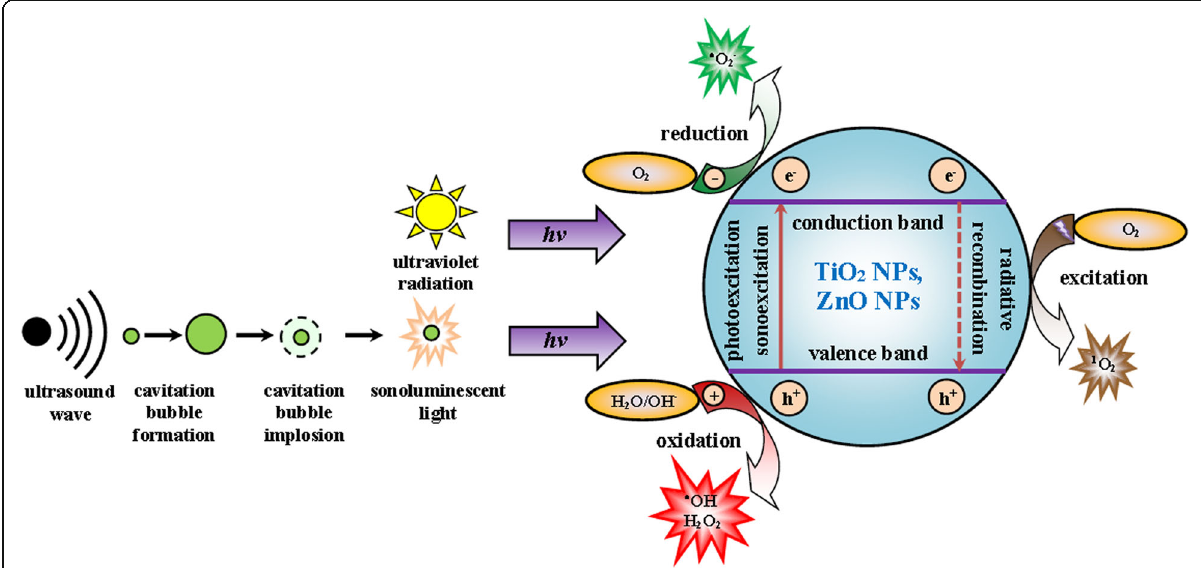
Fig. 1 Mechanisms of generating reactive oxygen species (ROS). ROS are generated on the surface of titanium dioxide or zinc oxide nanoparticles (TiO 2 NPs, ZnO NPs), exposed to ultraviolet (UV) radiation or ultrasound (US) wave in aqueous solutions. Semiconductor NPs can be excited by UV (photoexcitation) or US (sonoexcitation). The acoustic wave, while propagating in the liquid, induces the formation and the subsequent collapse of cavitation bubbles. During their implosion, the emission of the sonoluminescent light takes place. As a result of the TiO 2 NPs or ZnO NPs photo- or sonoexcitation, electron (e − ) transfers from valence band to conduction band, leaving behind hole (h + ). The follow-up process can be twofold. The electrons (e − ) together with holes (h + ) react with adjacent molecules (O 2 , H 2 O, OH − ), generating the formation of ROS ( (cid:129) O 2 − , (cid:129) OH, H 2 O 2 ). Alternatively, radiative recombination of electron-hole pair (e − +h + ) results in the emission of photon that transforms the oxygen molecule in the ground state (O 2 ) to the oxygen molecule ’ s excited state, singlet oxygen ( 1 O 2